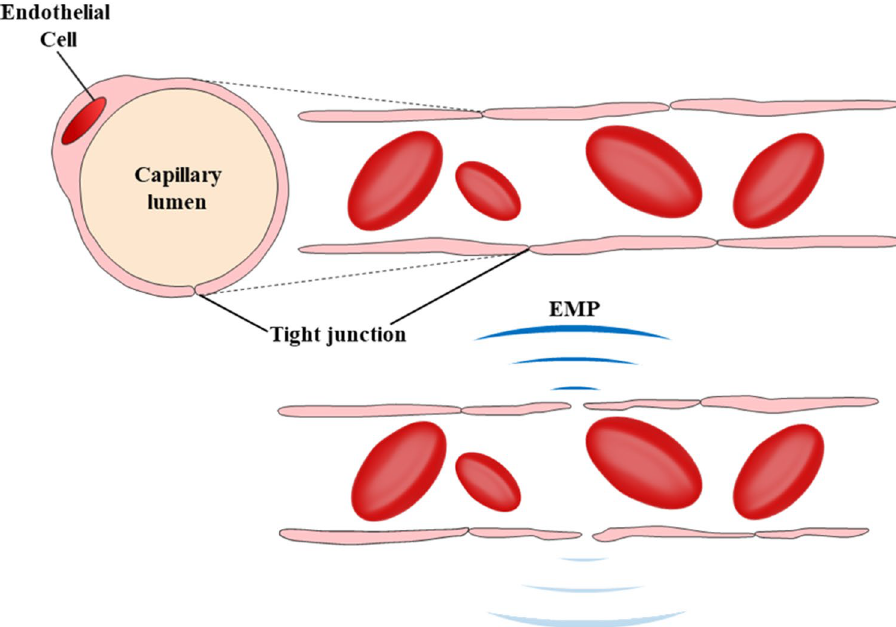
Figure 1. The schematic of BBB opening following EMPs. Without EMP (top) and with EMP (bottom). We used 3D Studio Max software, version 2020 (https:// www. autod esk. com/ produ cts/ 3ds- max/ overv iew) for the image.